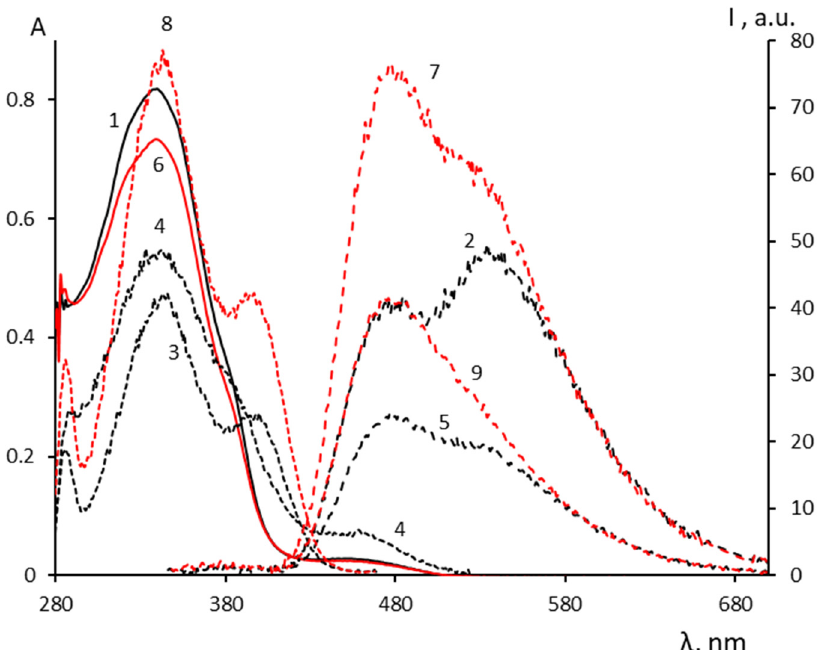
Figure 3. Absorption spectra (1, 6), fluorescence excitation spectra at λ reg = 477 nm (3, 8), 534 nm (4) and fluorescence spectra at λ ex = 338 nm (2, 7) and 399 nm (5, 9) of model 3 in the mixed solvent solution in the presence of Mg 2+ ions before (1–5) and after UV irradiation with the external source (6–9).